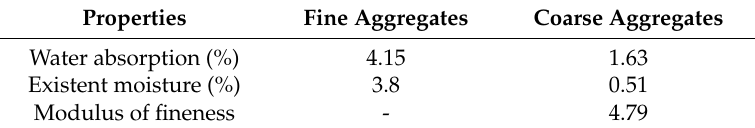
Table 2. Physical properties of fine and coarse aggregates.